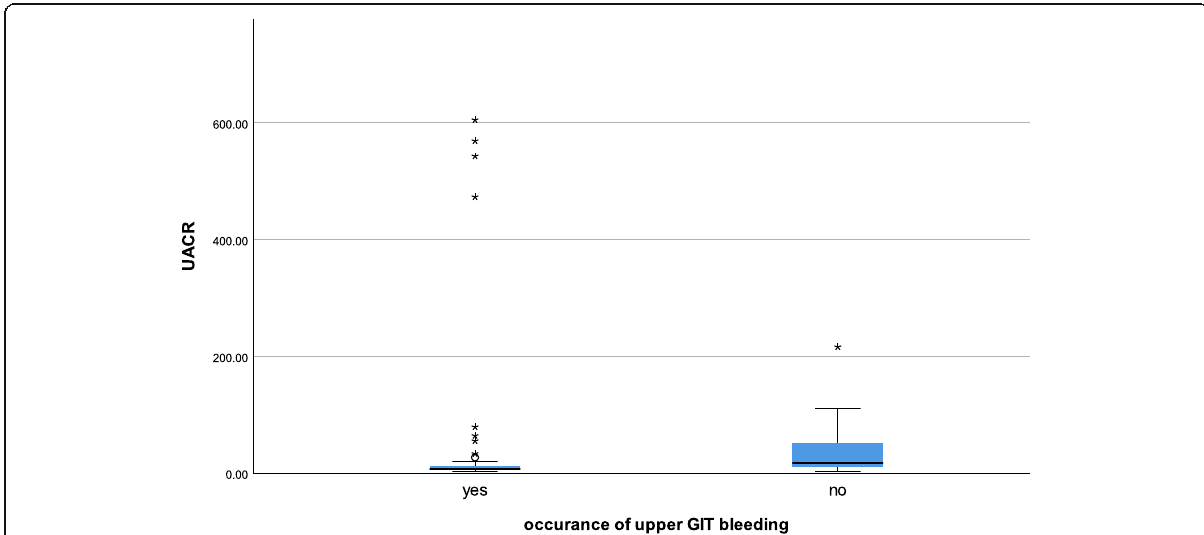
Fig. 1 The correlation between occurrence of upper gastrointestinal bleeding (UGIB) and urine albumin creatinine ratio (UACR). MMSE mini mental state examination